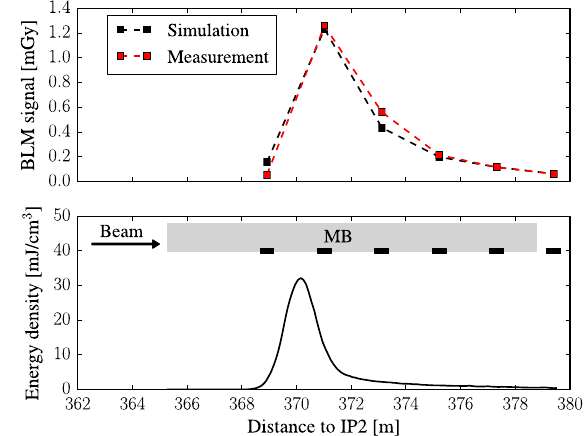
chamber.FIG. 5. Up: Comparison of BLM signals measured during the strong-kick event and simulated with FLUKA. Beam direction is from the left to the right. Down: FLUKA simulated peak energy deposition in the coils, integrated over the event. The gray box indicates magnet cold mass, black boxes indicate the location of